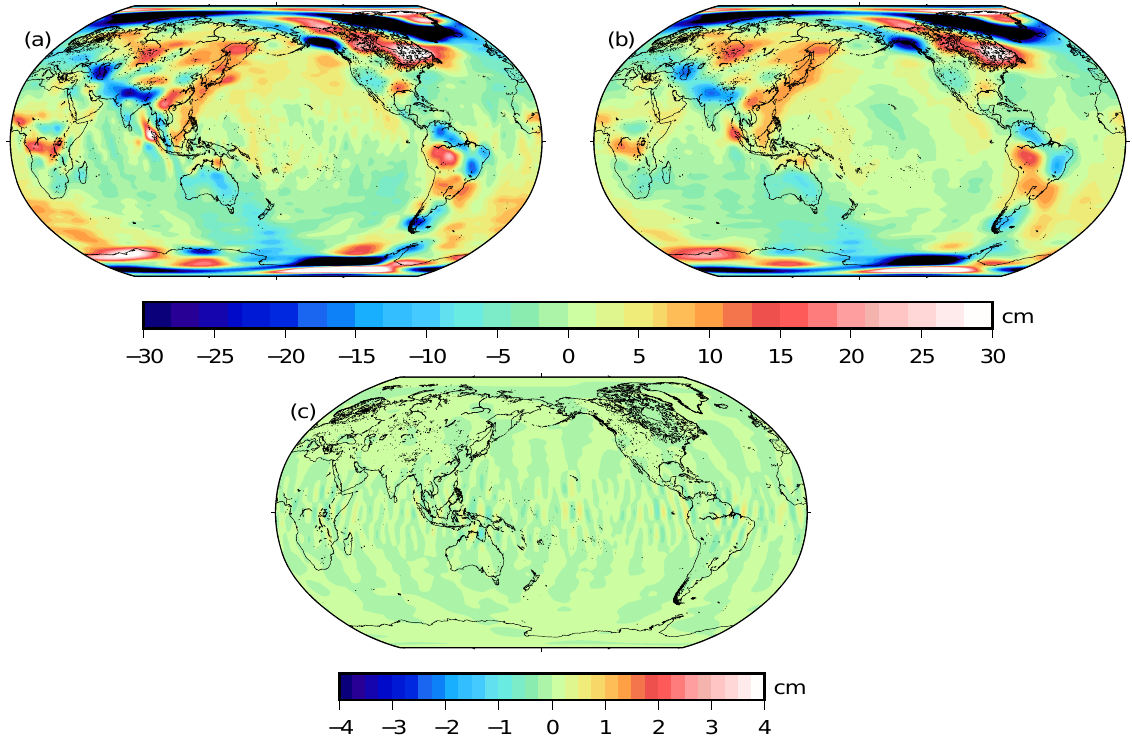
Figure 11. Gravity fields on January 2019 recovered from HUGG-01 ( a ) and CSR-RL06 ( b ), in terms of EWH [cm]. The gravity differences between those derived from HUGG-01 and JPL attitude products are shown in ( c